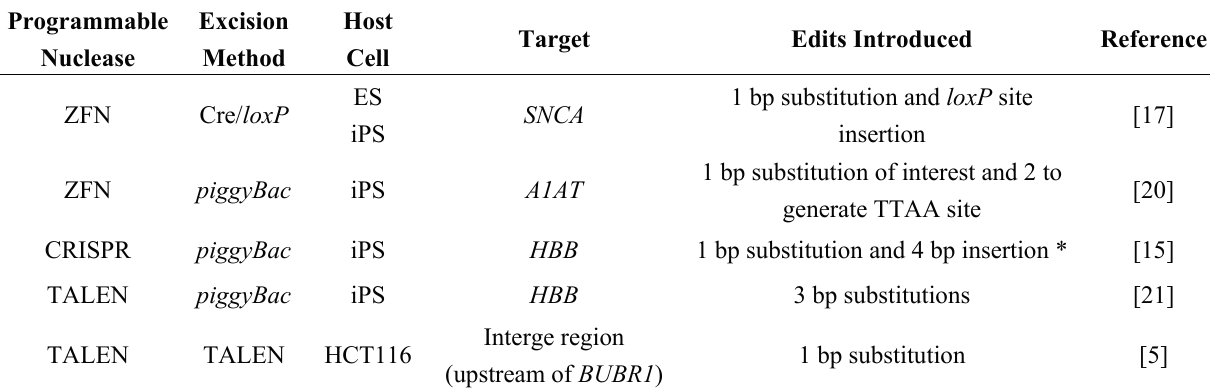
Table 2. Selection-dependent seamless genome